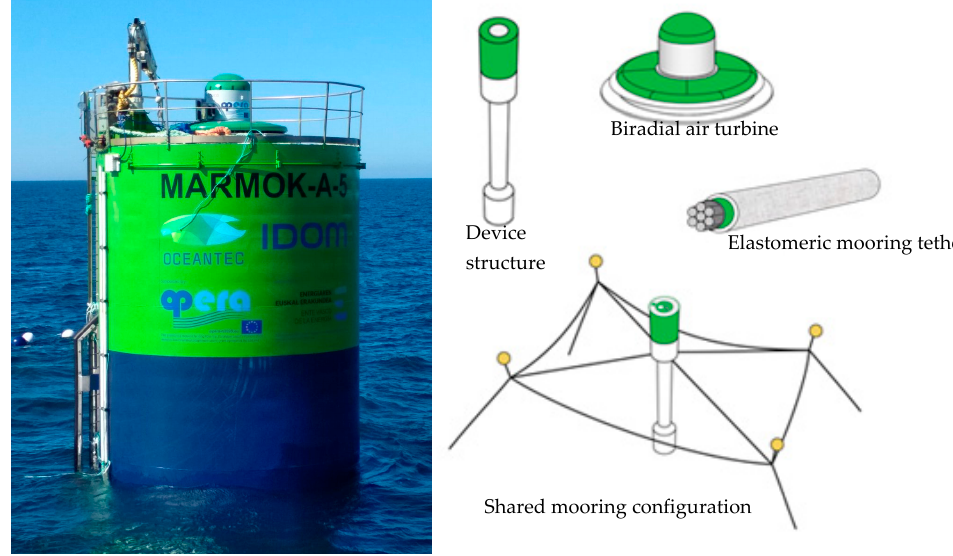
Figure 4. MARMOK-A-5 device. Device deployed at BiMEP (left-side) and device’s main components (right-side).